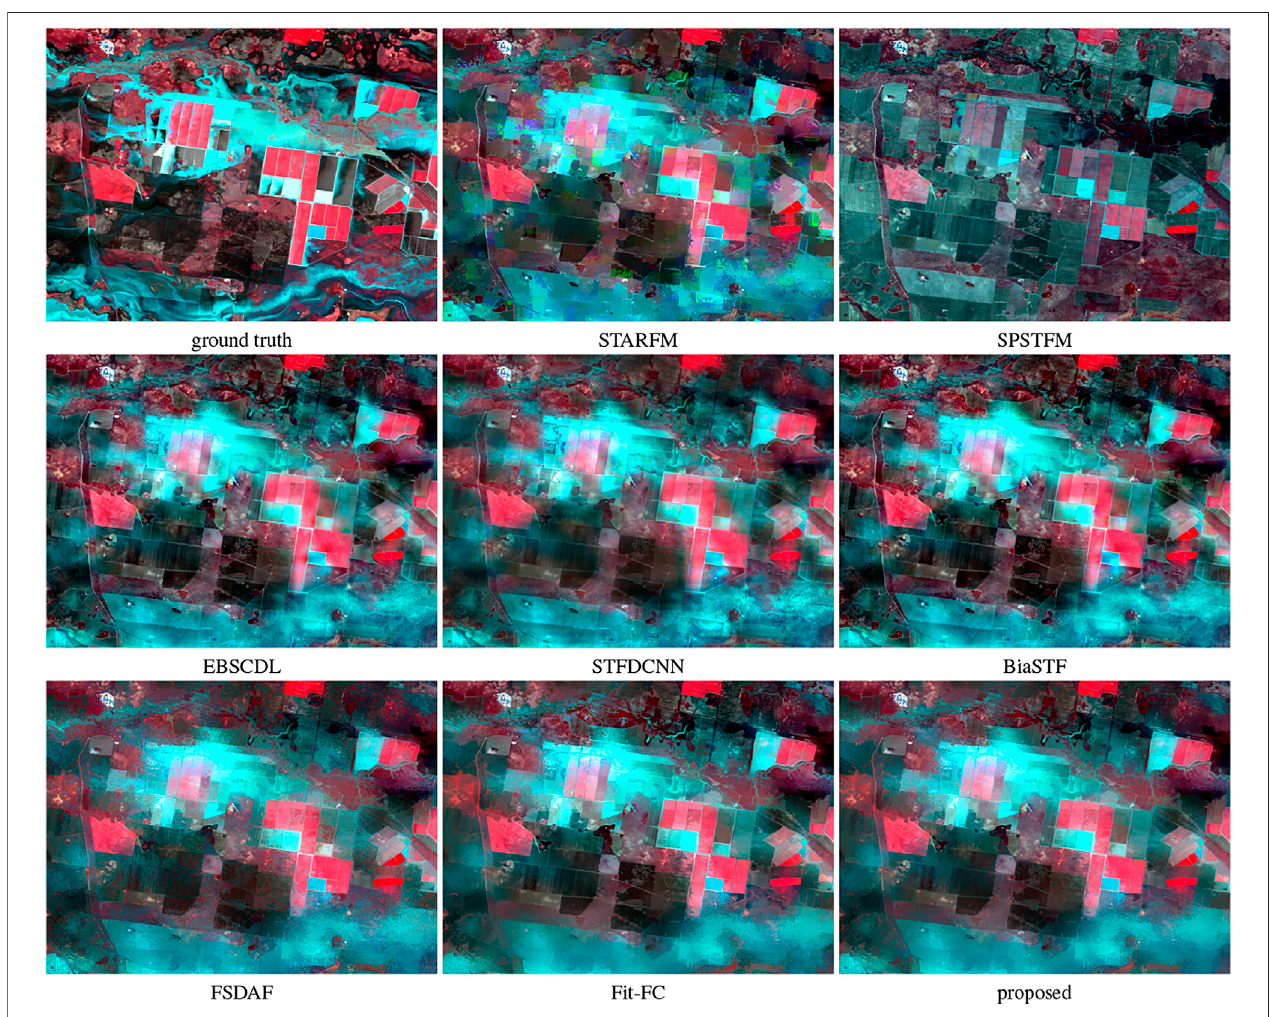
FIGURE 4 | Manifestation of the large region of the NIR, red, and green bands of LGC image 3 for fl ood observation.